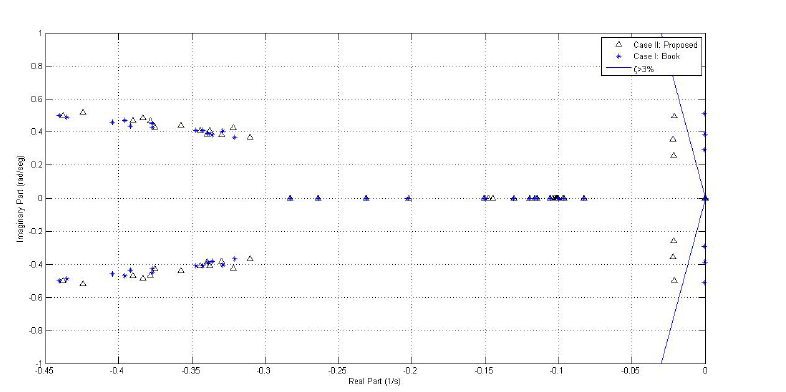
Figure 35. Eigenvalues in heavy load operation